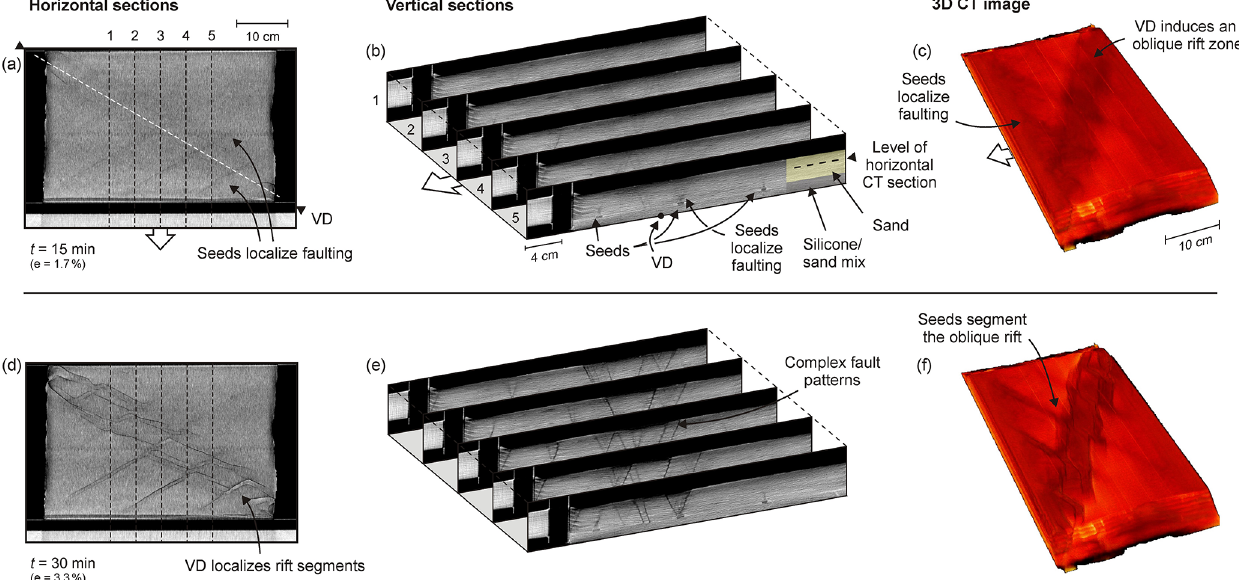
Figure 8. CT analysis of Model L (30 ◦ oblique VD, − 30 ◦ oblique seeds, CT-scanned rerun of Model K). (a, d) Horizontal sections through the brittle layer. (b, e) Serial cross sections. (c, f) 3D CT images. Note that the colours in these images represent CT-scanning intensities and are not to be interpreted as a measure of model surface altitude.